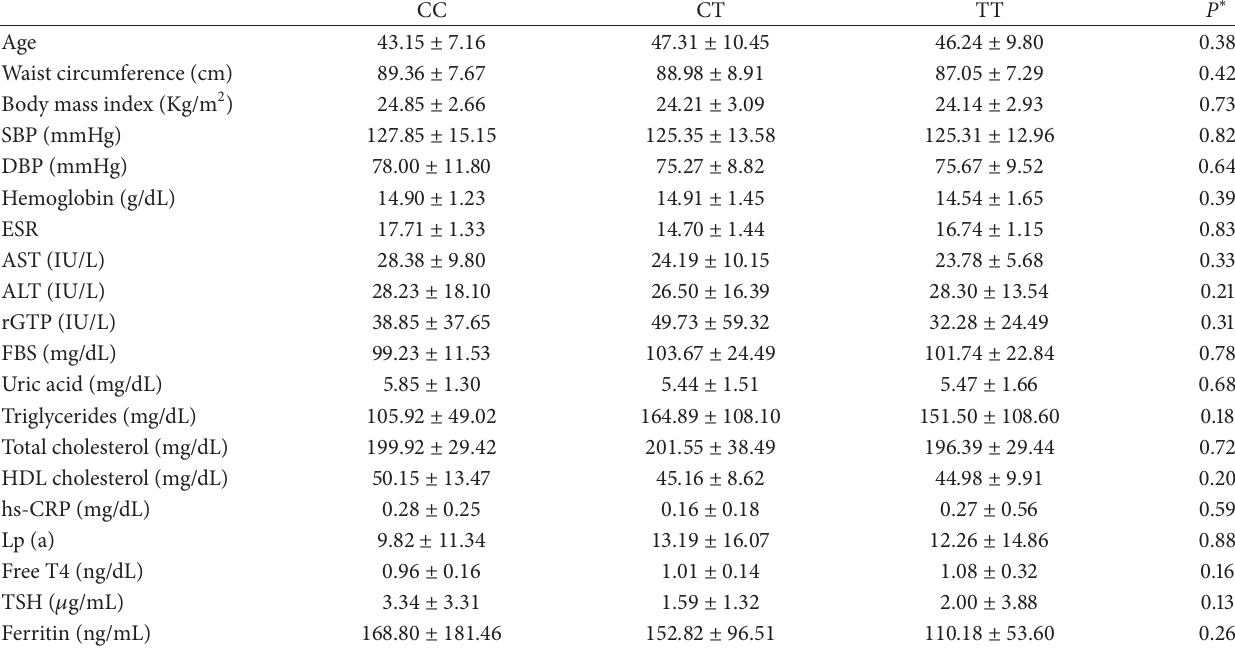
Table 4: Risk factors for atherosclerosis according to CD 14 − 159 genotypes in subjects with H. pylori